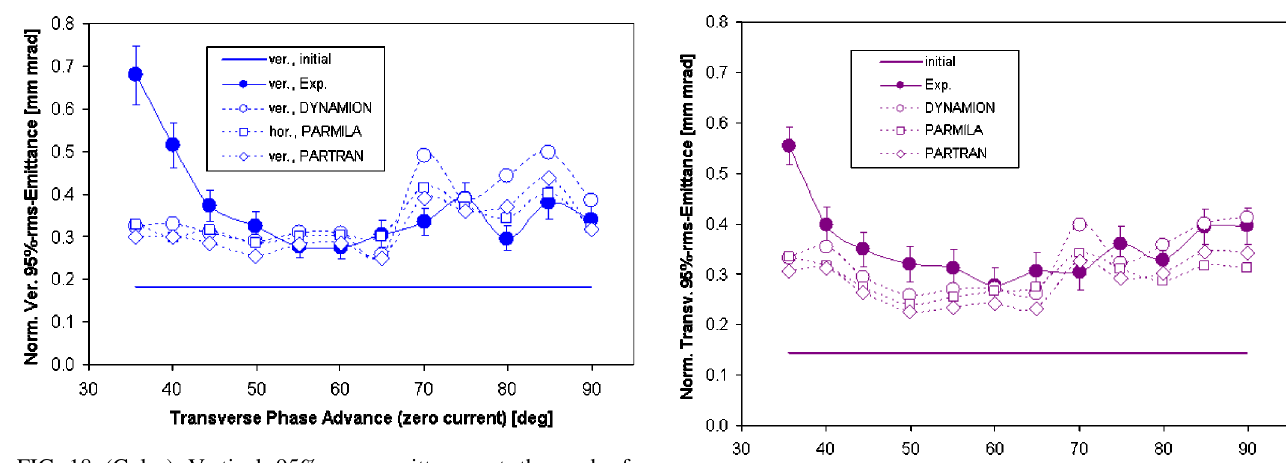
.FIG. 18. (Color) Vertical 95% rms emittance at the end of the DTL as a function of the transverse zero current phase advance (cid:4) o .